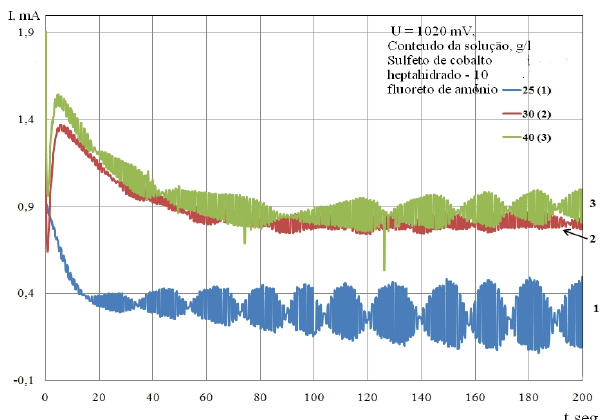
Fig. 2. The oscillatory behavior in current during the anodic synthesis of CoO(OH) in the presence of different concentration of ammonium fluorite. Reproduced from [31] with author´s permission